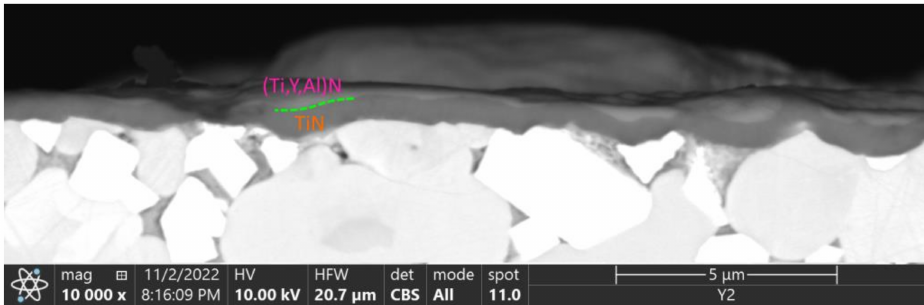
Figure 4. General wear pattern of the coating (SEM, after 16 min of cutting at f = 0.25 mm/rev, a p = 1.0 mm, and v c = 300